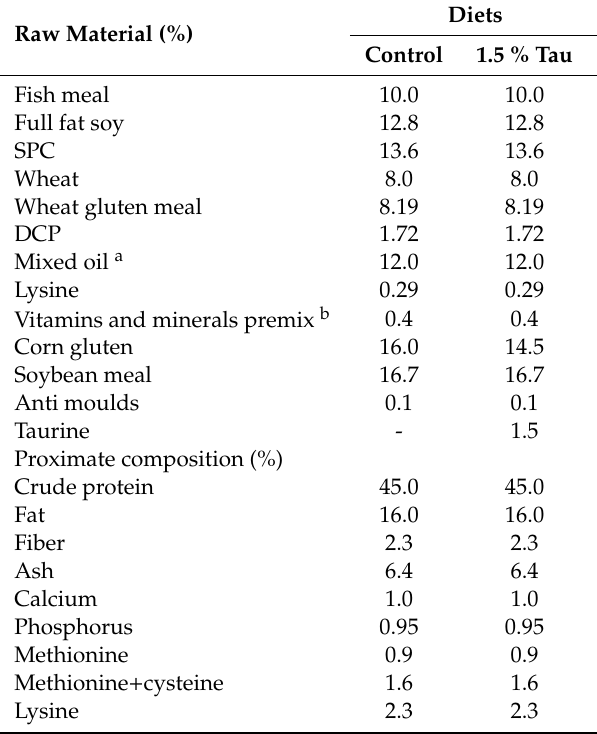
Table 1. Ingredients (%) and proximate composition (%) of experimental diets. Raw Material (%)